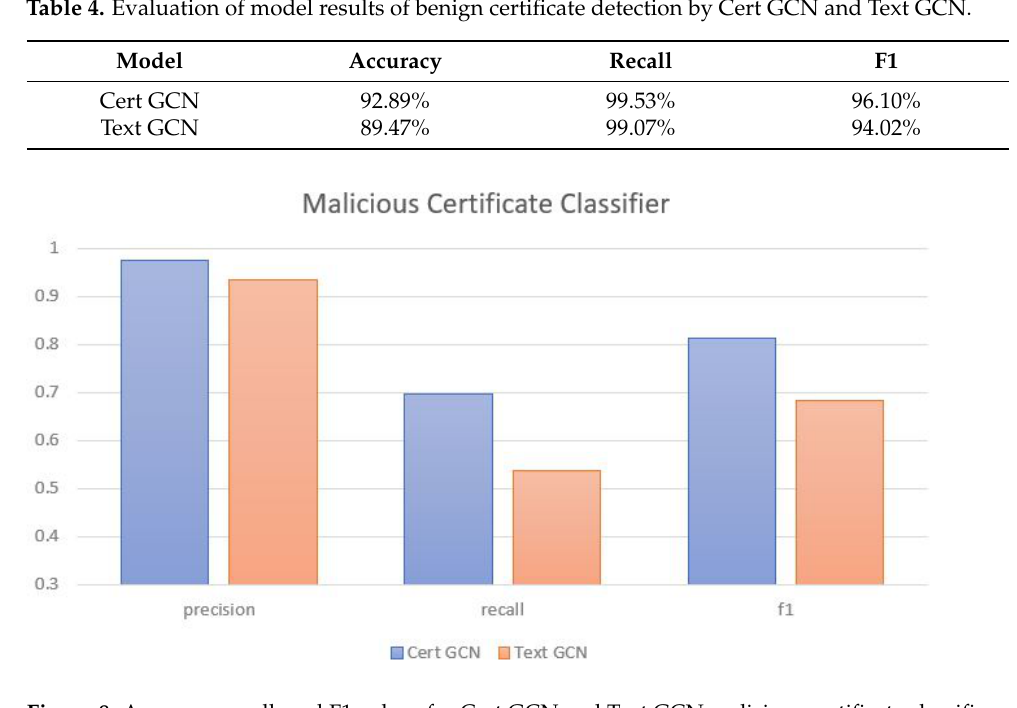
Figure 8. Accuracy, recall, and F1 values for Cert GCN and Text GCN malicious certificate classifiers.